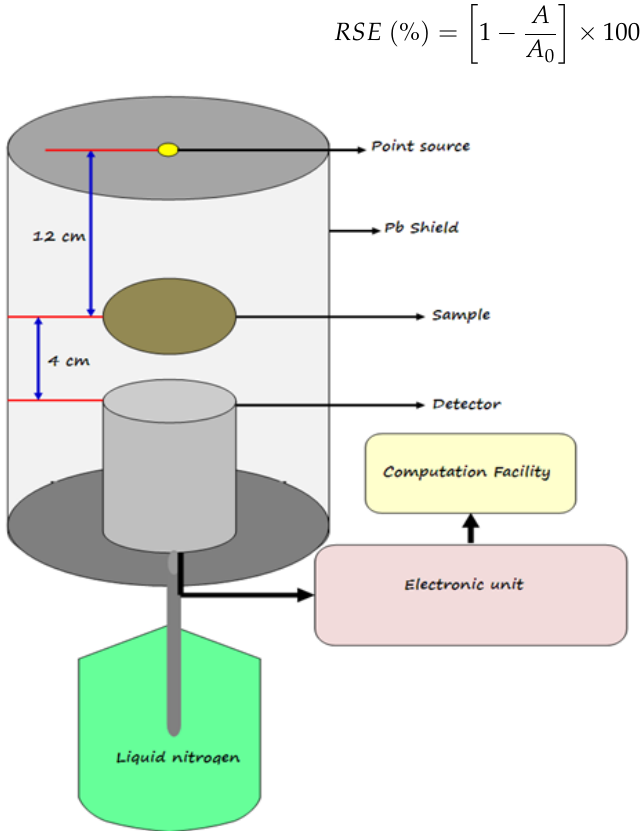
Figure 3. The geometry of the experimental work.